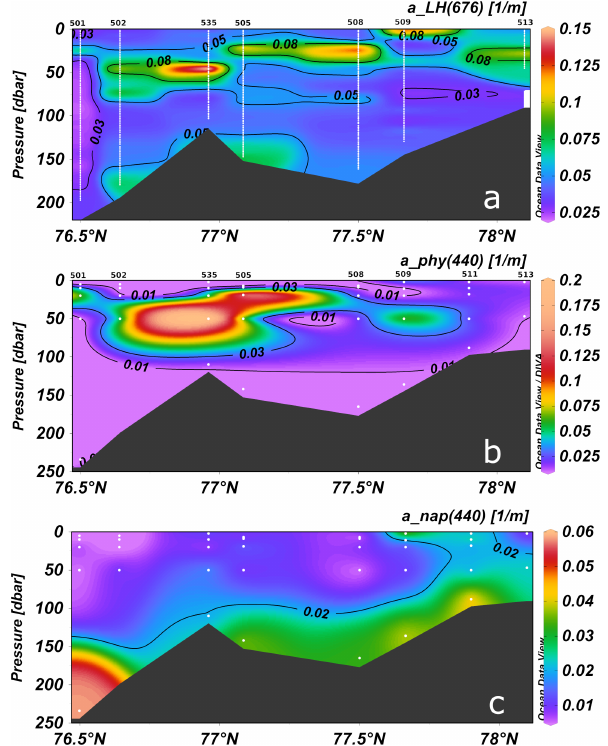
Figure 8. Section plots of (a) absorption line height at 676nm ( a LH (676)) (data from the ac-s), (b) absorption by phytoplankton (data from the water samples), and (c) absorption by non-algal par- ticles (NAPs) (data from the water samples) all at 440nm. White points indicate sample locations. Plots are made with Ocean Data View (Schlitzer, Reiner, Ocean Data View, https://odv.awi.de/, last access: 30 January